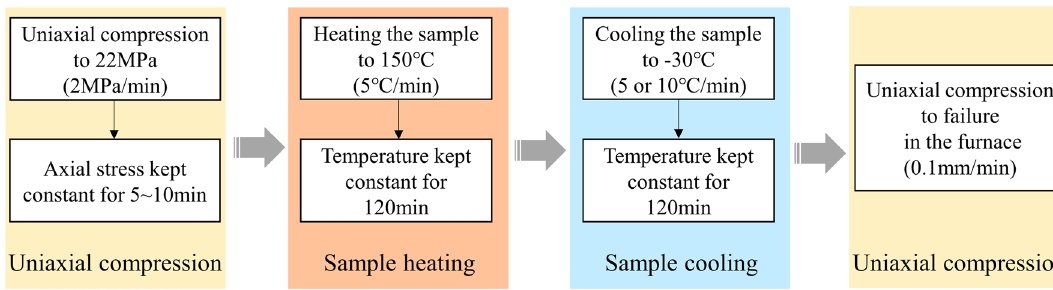
Fig. 2 Experimental flow chart